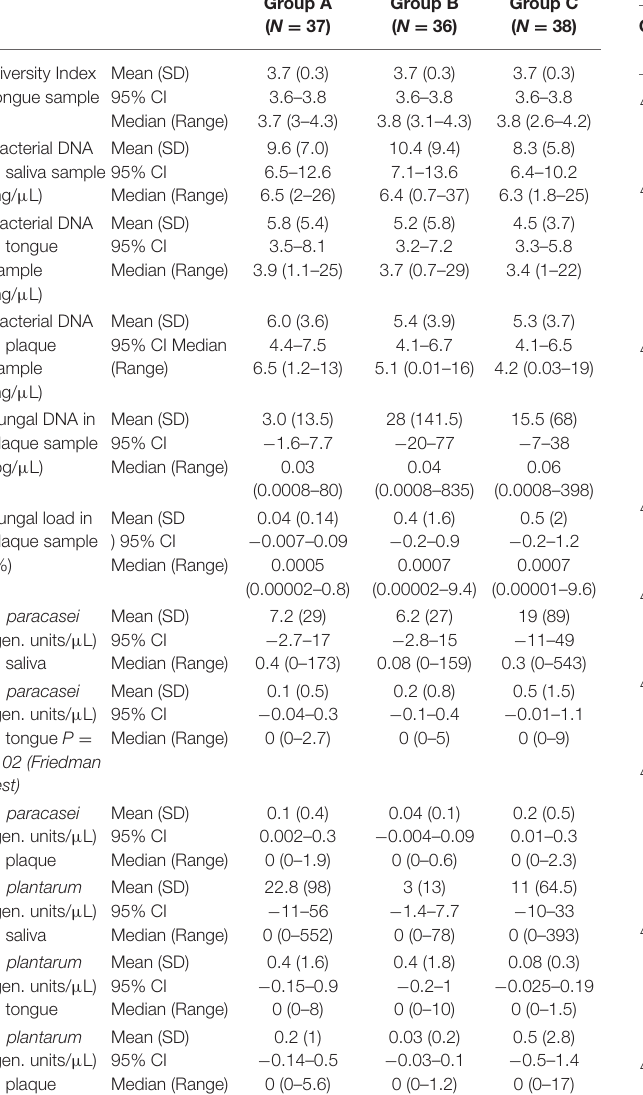
TABLE 2 | Primary and secondary study outcomes in per-protocol (PP)